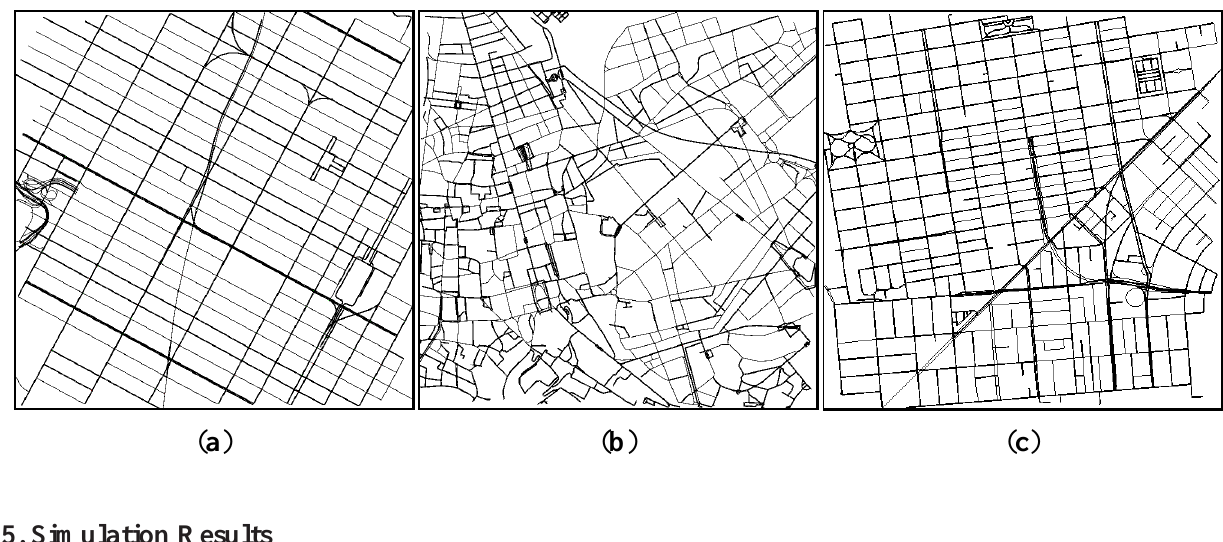
Figure 2. Scenarios used in our simulations as street graphs in SUMO: ( a ) fragment of the city of New York (USA); ( b ) fragment of the city of Rome (Italy); and ( c ) fragment of the city of San Francisco.